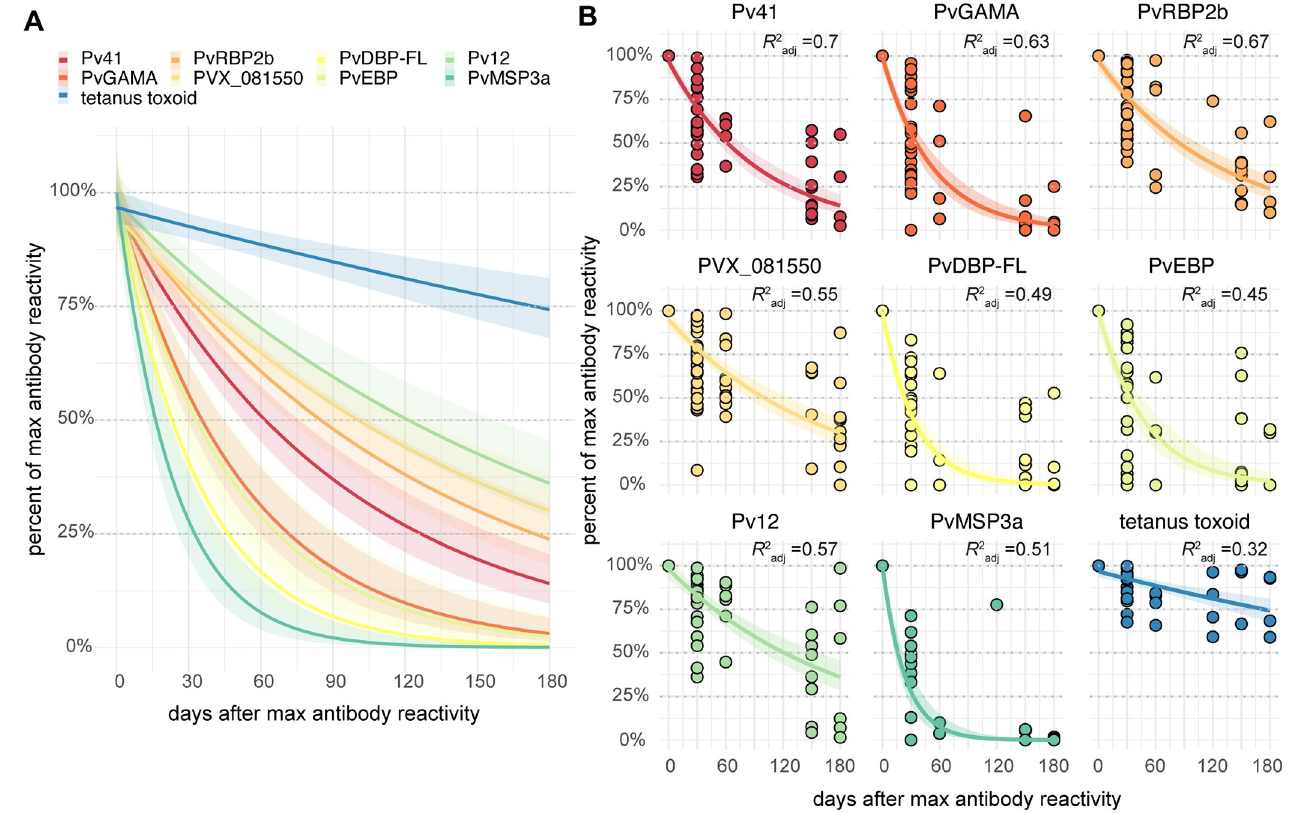
Fig 3. Kinetics of antigen-specific IgG responses after acute vivax malaria. (A) Exponential fit curves for antibody reactivities normalized as the percent of maximum antigen-specific IgG across all time points for each individual and for each antigen and plotted against days from the timepoint with maximum antibody reactivity. Bands represent 95% confidence intervals. (B) Same exponential fit curves in (A) with actual reactivity data. A small perturbation of 0.0001 was added to percent of maximum reactivity to avoid taking the log of